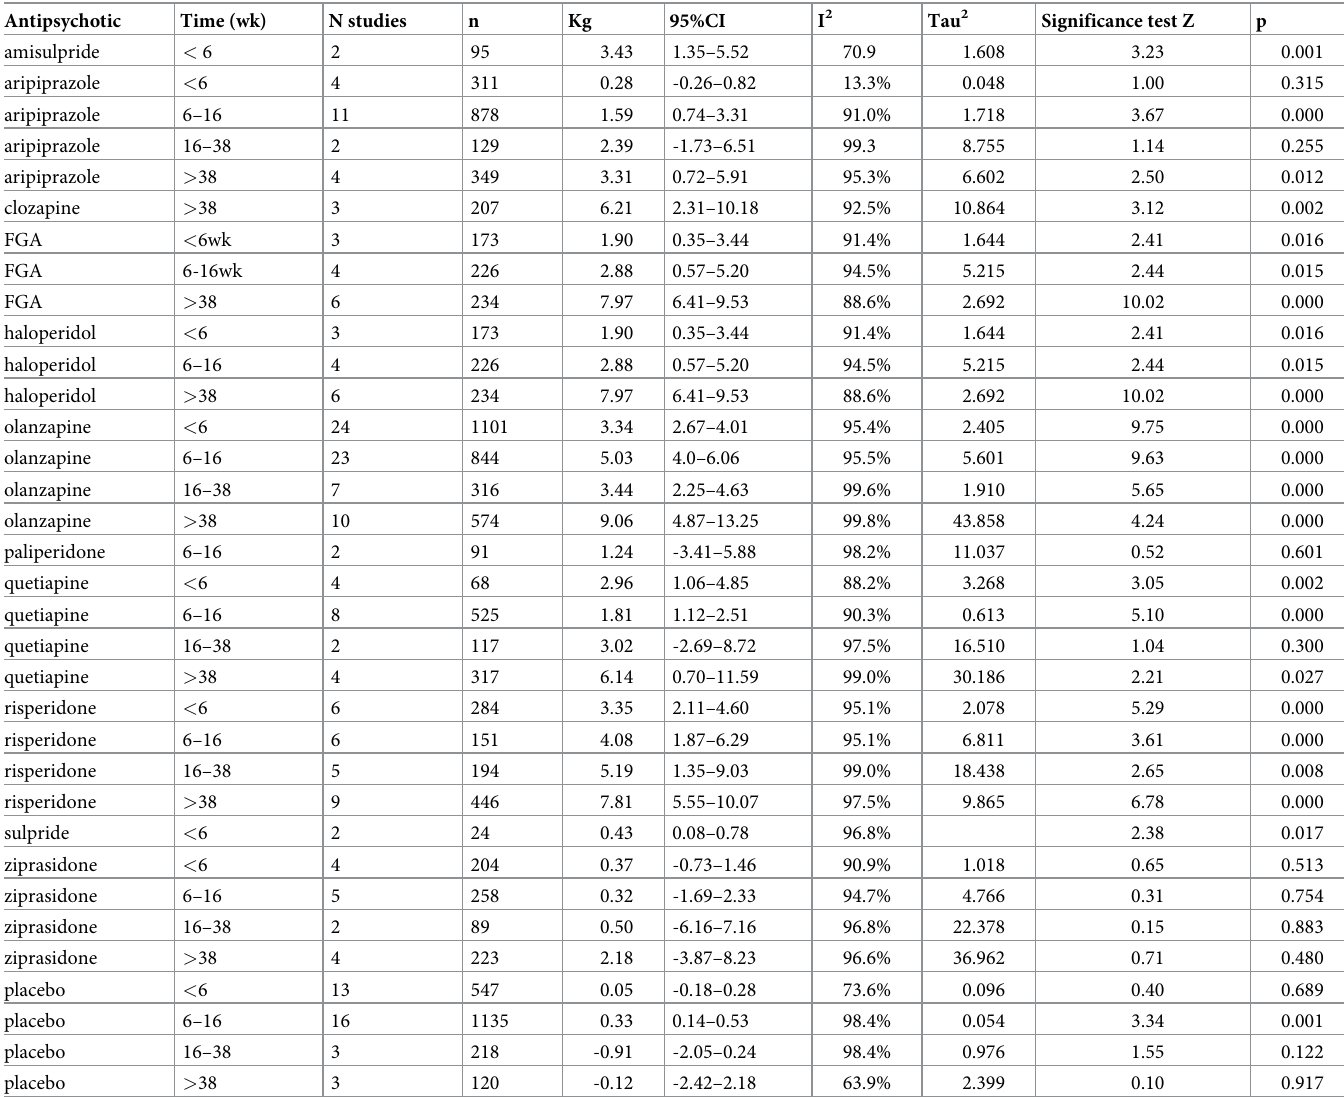
Table 1. Results AP-naive